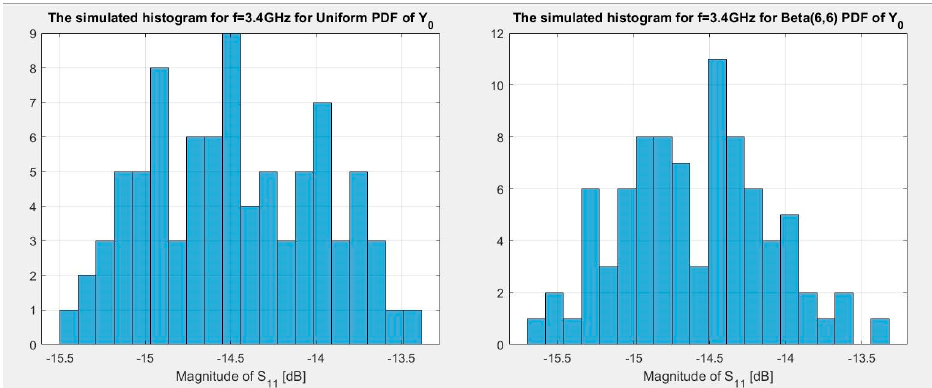
Figure 7. Histogram of | S 11 | obtained from the measurements and simulation results for σ y0 = 0.025 mm for antenna design from Figure 2 for the frequency of 34.5 GHz.